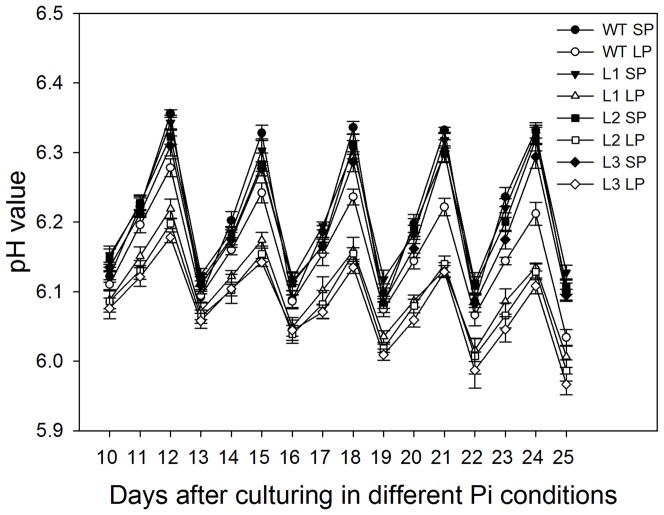
The pH value of nutrient solution in which maize plants were cultured.Maize seedlings were cultured in SP (1,000 µMKH2PO4) nutrient solution for 20 days, then divided into two groups and grown separately in SP and LP (5 µM KH2PO4) nutrient solutions for an additional 25 days. After 10 days of culturing in different Pi conditions, the pH value of nutrient solution was measured every day. Each of maize plants was cultured in 1 liter of nutrient solution. The initial pH value of nutrient solution was 6.0±0.1. Nutrient solution was replaced every 3 days. In this figure, on the 10th, 13th, 16th, 19th, 22th and 25th day of low Pi stress, the nutrient solution was replaced. Values are means ± SD (n = 5). WT, wild type; L1, L2 and L3, transgenic lines; SP, sufficient phosphate (nutrient solution containing 1,000 µM KH2PO4); LP, low phosphate (nutrient solution containing 5 µM KH2PO4).